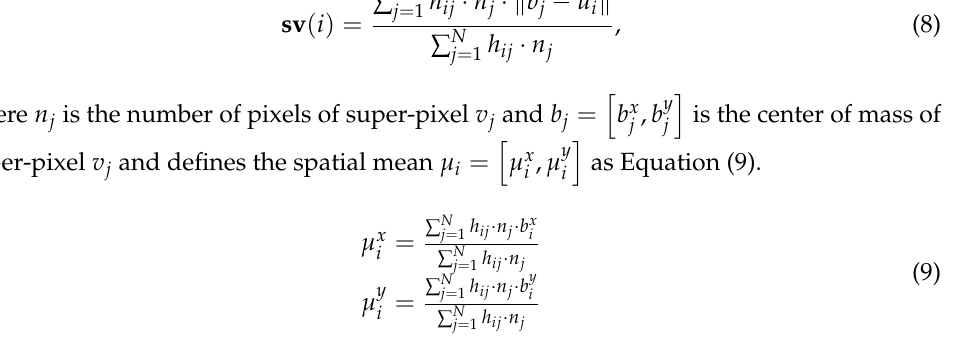
Figure 5. The results of super-pixel segmentation. ( a ) Image I, ( b ) Image II. After generating the SLIC super-pixel model, a construction graph G = (V,E) is ob- tained, where V represents the node, E represents the undirected edge connecting the nodes, and the saliency values of adjacent nodes are very similar with high probability.